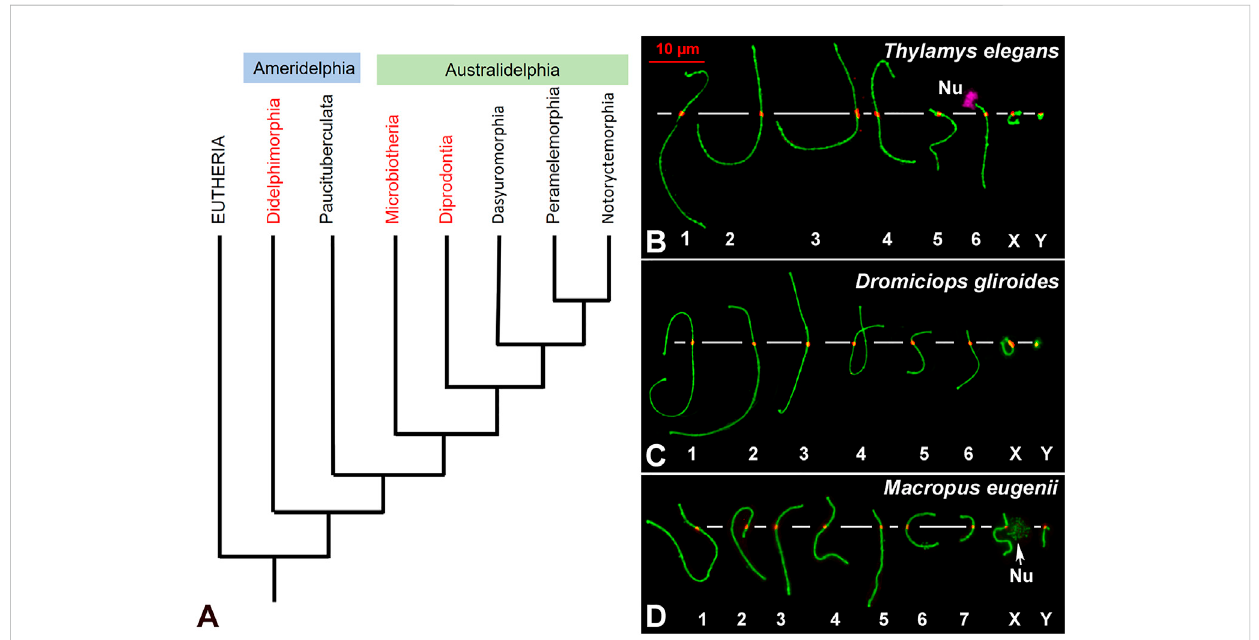
FIGURE 1 (A) . Phylogenetic relationships of extant marsupial orders. The arrangement presented is based on the phylogeny published by Duchêne and coworkers (Duchêne et al., 2017). Although the topology of the tree is still controversial, Microbiotheria is grouped to Australidelphia in all the trees consulted. The Orders included in this study are highlighted in red. (B – D) . Meiotic karyotypes of the three studied species: SYCP3 in green and centromeres in red. Bivalents are ordered by size, according to previous reports. In Thylamys elegans (B) the position of the NOR (Nu) on the short armof bivalent6 wasdetected using anti- fi brillarinantibody (pink).The position of theNOR on theXchromosome of Macropus eugenii wasdetected by an accumulation of SYCP3. Scale bar in red: 10